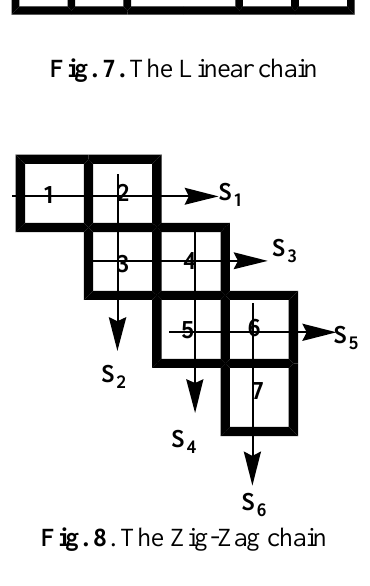
Fig. 7. The Linear chain